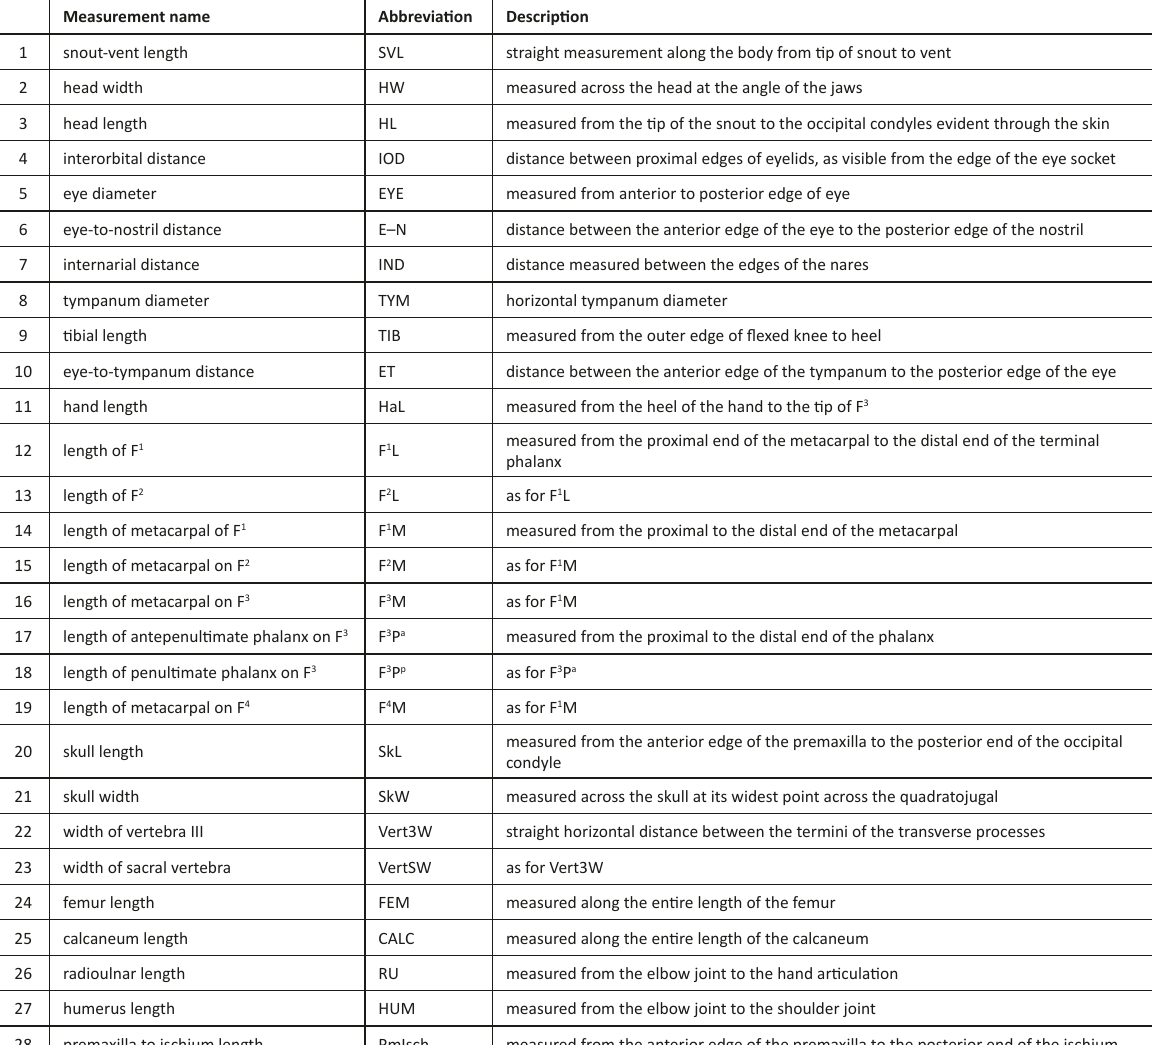
Table 1. Measurements taken on specimens of five species from the Península de Paria in northeastern Venezuela. Measurements 1–10 were taken from preserved specimens using digital calipers, whereas the remaining measurements were taken in units of pixels from x-ray images. The latter were only used to calculate length ratios, not to provide absolute measurements. Numbers associated with finger (F) characters denote the finger on which the character was